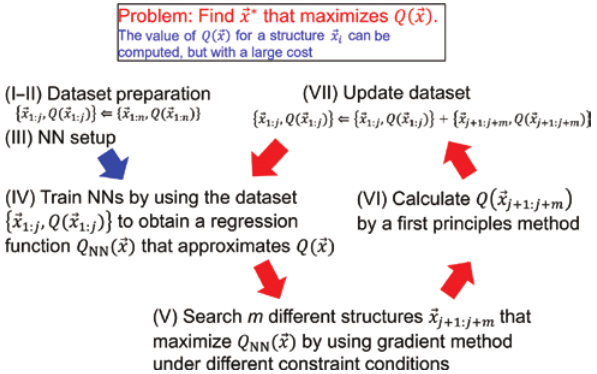
Figure 1: The iterative optimization proposed in this